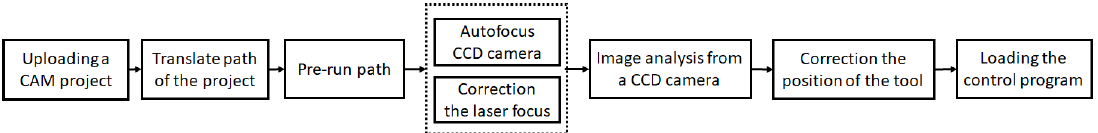
Figure 3. Scheme for determining the focal length of laser radiation and CCD camera. Figure 4. Scheme of the sequence of operations of the system for correcting the points of the planned trajectory in the preprocessing of laser welding using computer vision systems.